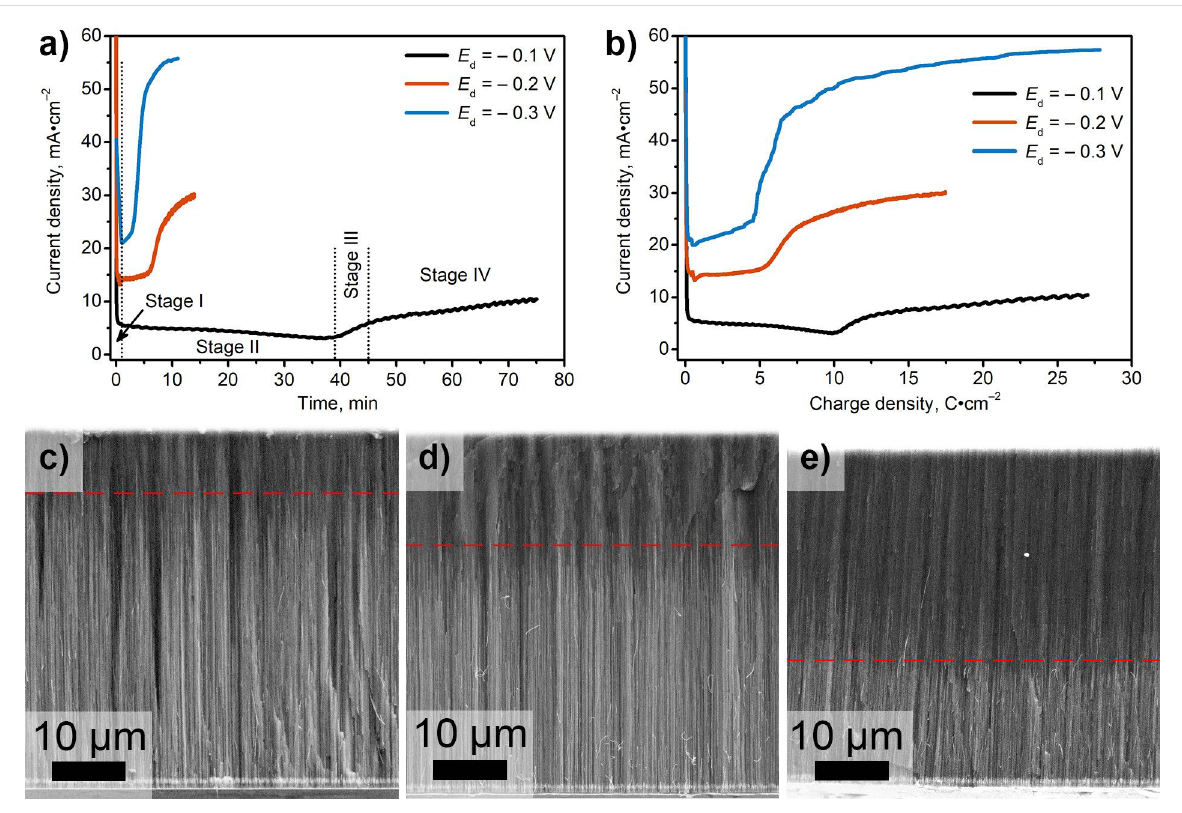
Figure 2: Electrochemical responses recorded during the electrodeposition of the third Cu segment: (a) j – t curves and (b) j – q curves. Characteristic stages of the templated electrodeposition are indicated in panel (a) on the example of the current transient recorded at E d = − 0.1 V. Cross-sectional SEM images of the AAO/Cu/Au/Cu nanocomposites obtained at different deposition potentials of the third Cu segment: (c) E d = − 0.1 V, (d) E d = − 0.2 V, and (e) E d = − 0.3 V. Dashed red lines indicate the position of the main growth front of the Cu nanowires.